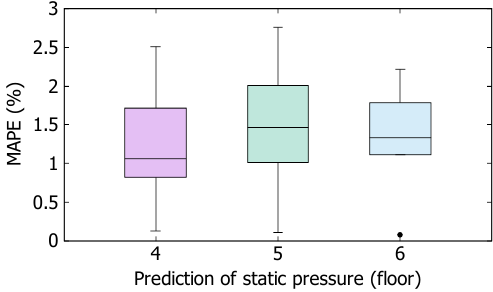
Figure 15. Distribution of prediction